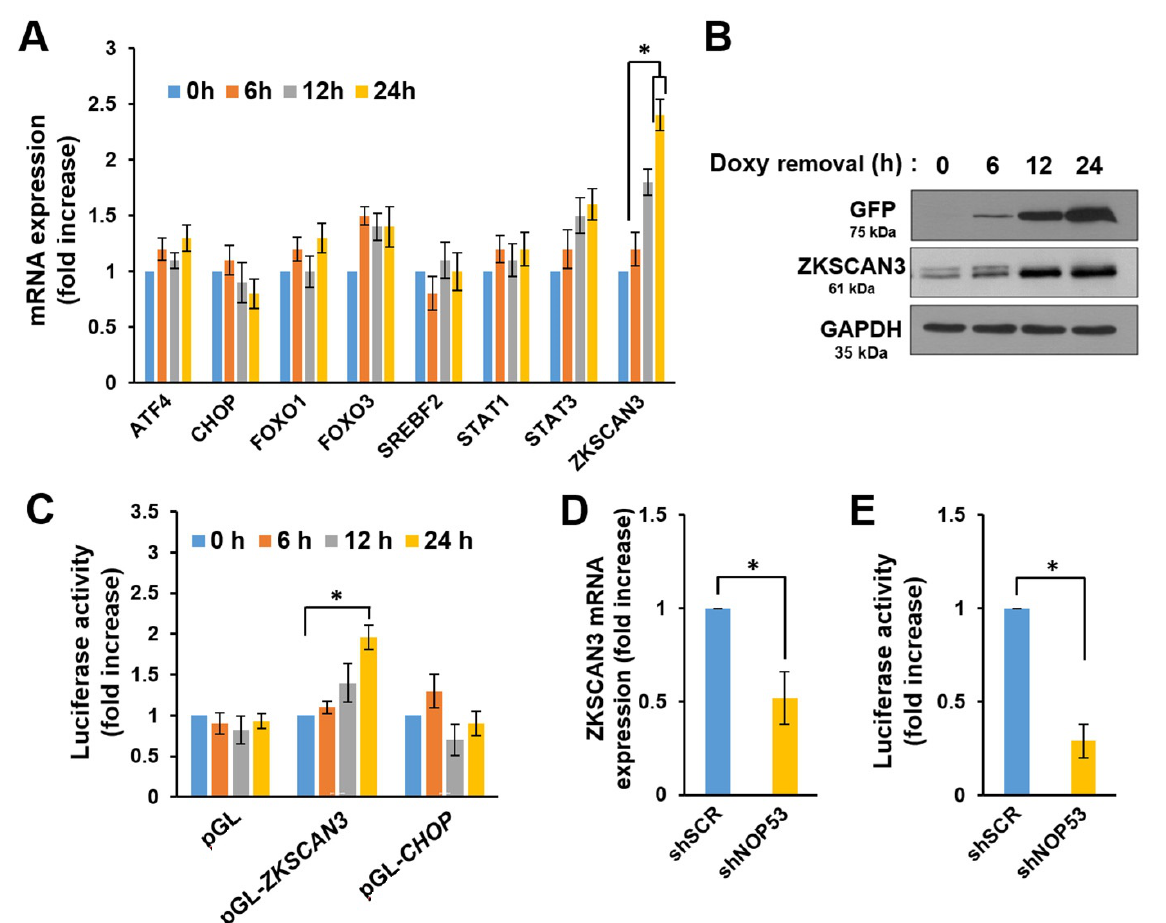
Figure 3. NOP53 transcriptionally regulates ZKSCAN3 . ( A ) LN18 cells were transduced with doxycycline-inducible (Tet/OFF system) Ad-NOP53 in the presence of 20-ng/mL doxycycline for 24 h. Then, doxycycline was removed at the zero time point, and the cells were harvested after 6, 12, and 24 h. Real-time qPCR was performed as described in “Methods”. Data obtained from three independent experiments represent a fold increase in the mRNA level of each transcriptional factor relative to the basal transcription level. The amount of target mRNA was normalized by determining the level of GAPDH mRNA. * p < 0.01. ( B ) The cells were treated as indicated in “A”, and the lysates were subjected to Western blots using anti-GFP (ectopic NOP53) or anti- ZKSCAN3 antibodies after normalization to GAPDH . ( C ) LN18 cells transduced by Ad-NOP53 in the presence of 20-ng/mL doxycycline were transfected with mock (pGL) or ZKSCAN3 promoter (pGL- ZKSCAN3 ) plasmid for 24 h. Then, a luciferase assay was performed at the indicated times after the removal of doxycycline. The histogram represents the fold increase relative to the luciferase activity at the zero time point. Data were obtained from three independent experiments and shown as the means ± SD; * p < 0.01. ( D , E ) Real-time qPCR of the ZKSCAN3 mRNA expression ( D ) and a ZKSCAN3 promoter assay ( E ) on the shSCR and shNOP53 cells were performed. Data were obtained from three independent experiments and shown as the means ± SD; * p < 0.01.